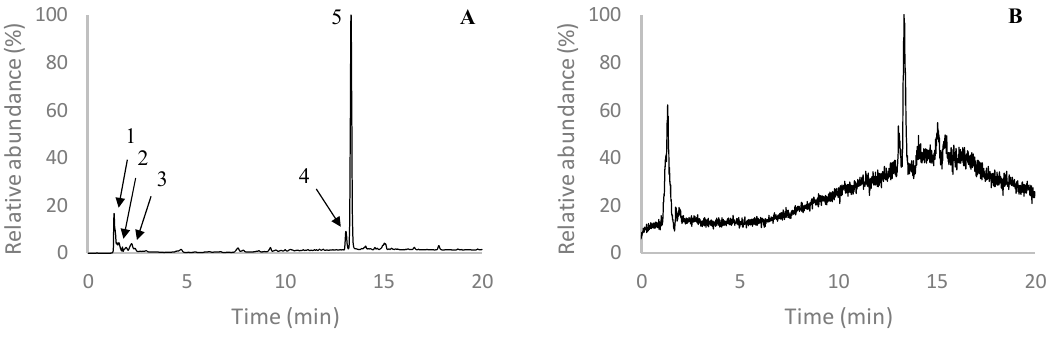
Figure 4. Chromatographic profile at 280 nm ( A ) and total ion chromatogram ( B ) of F2. Peaks marked with numbers correspond to the tentatively identified compounds represented in Table 2.